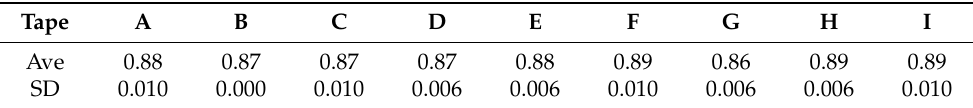
Table 4. Emissivity values of the nine tapes under study.